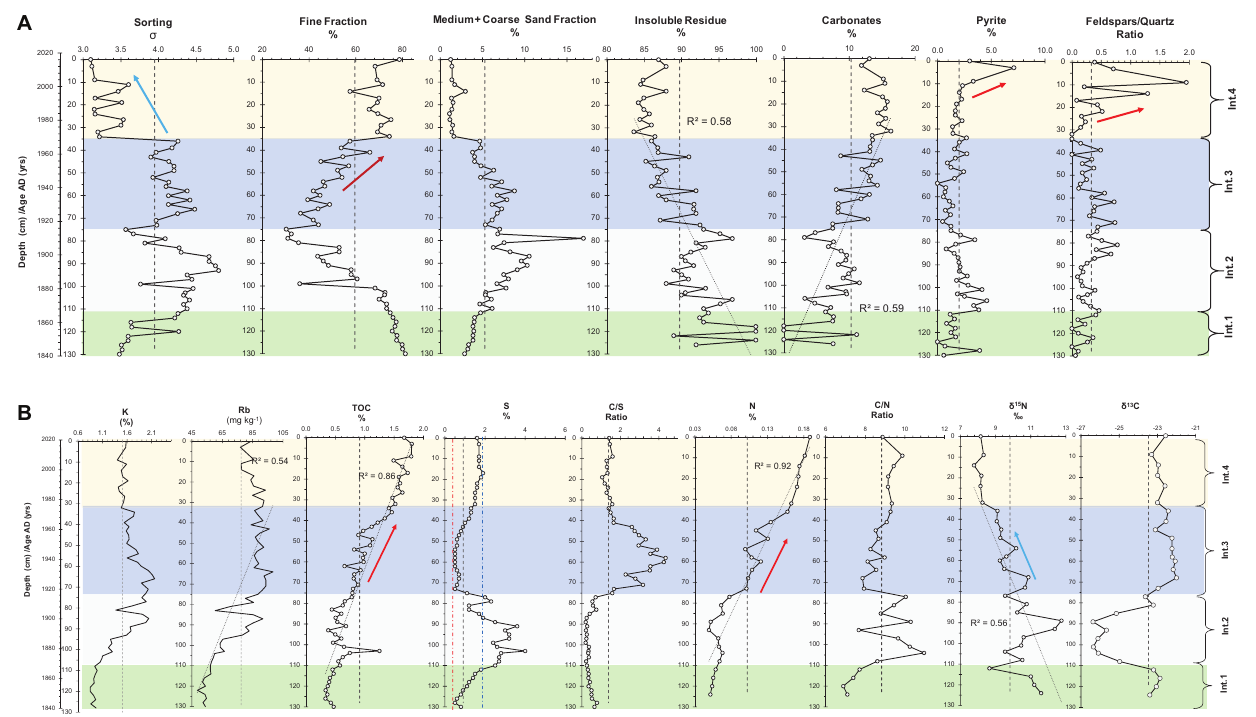
FIGURE 2 | Graphs as a function of depth and age (Anno Domini or AD) of: (A) sorting, percentage of fine fraction, medium and coarse sand, carbonates, and pyrite and feldspar/quartz ratio; (B) SMGS (in %; sediment mean grain size), TOC (in %; total organic carbon), C/S, N (in %), δ 15 N (in analyzed data, four intervals (Int.) are highlighted. Red and blue dashed vertical lines correspond to global baseline values for shale (Turekian and Wedepohl, 1961) and for local fine sediments (Pinto et al., 2019), respectively. The arrows highlight variables with increasing (in red) or decreasing (lower) concentration trends. The regression line for some variables and their R 2 value are also presented.